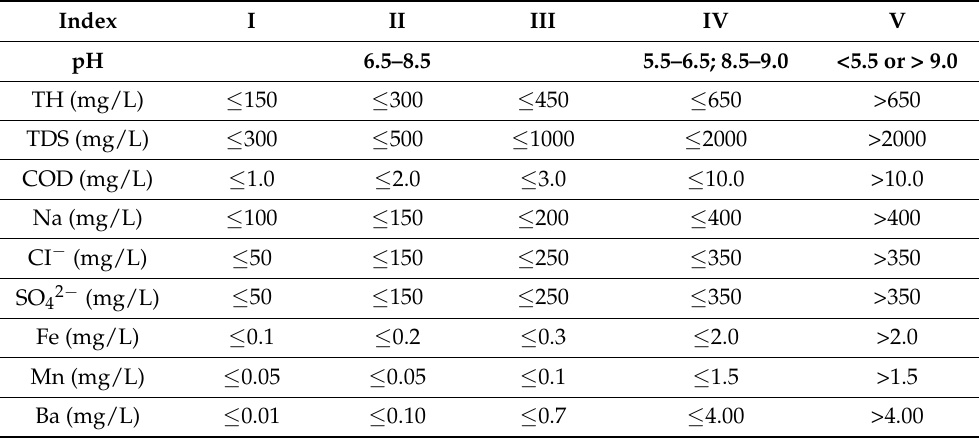
Table 1. Groundwater quality evaluation